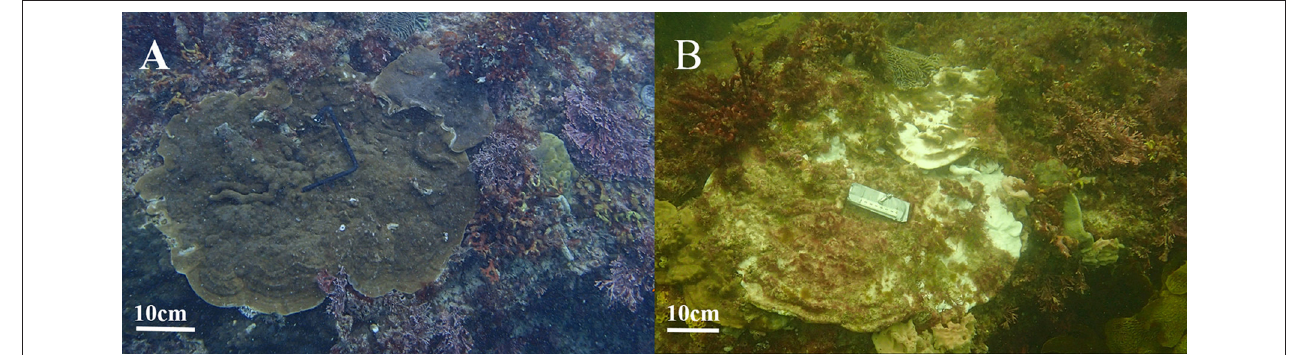
FIGURE 3 | Underwater photographs of coral colonies from Three Mile Reef South in Marmion Marine Park showing (A) healthy coral colonies in 2014 before the 2016 Marine Cold Spell and (B) bleached Montipora mollis colonies with turf algae overgrowth after, in January, 2017. Photo credits: C. Tuckett.